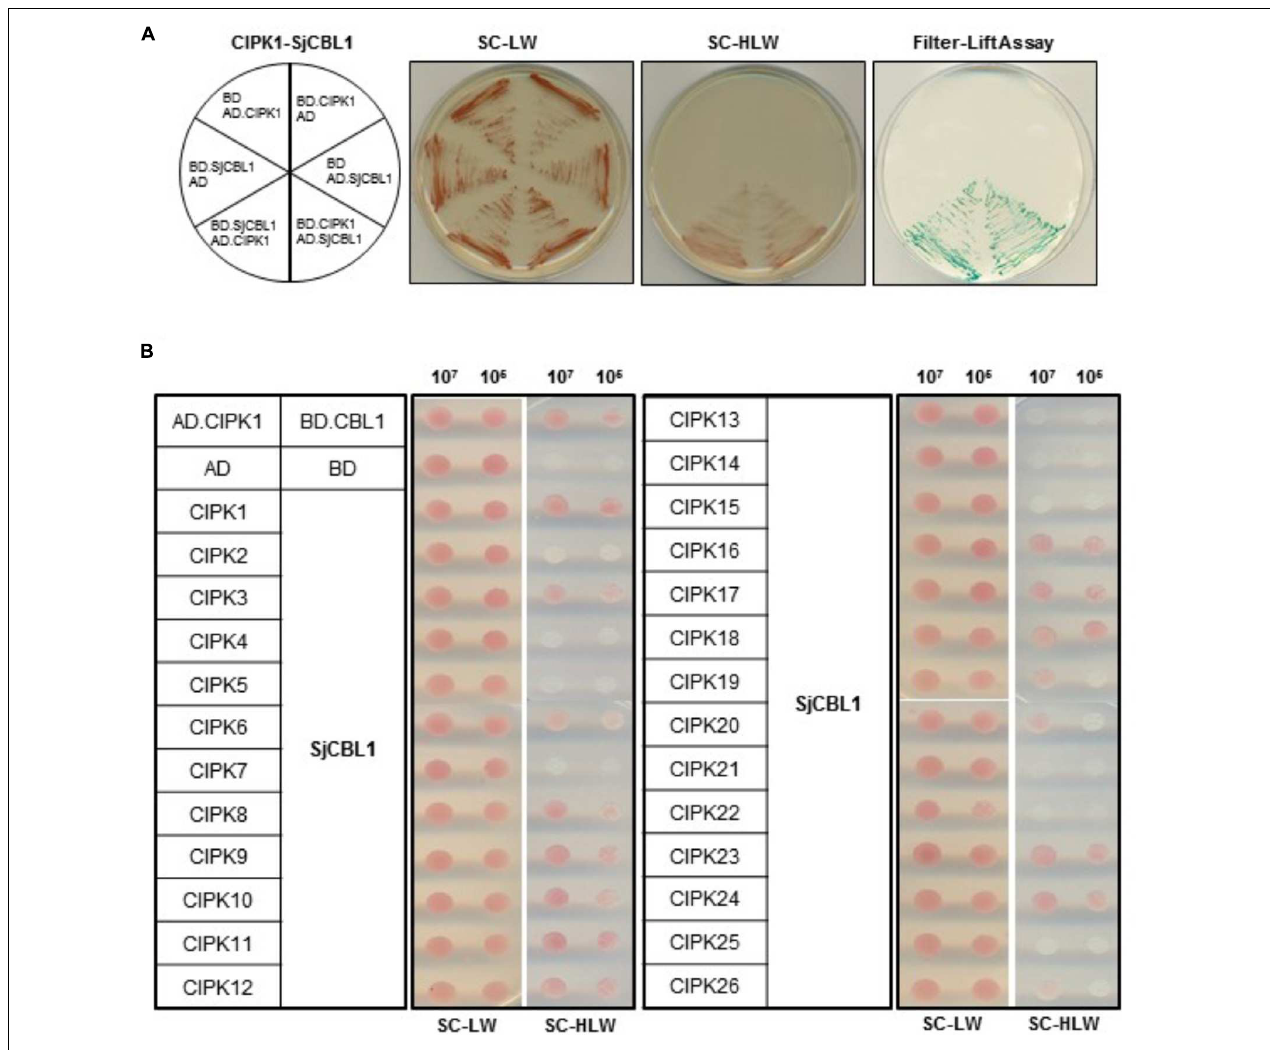
FIGURE 4 | A yeast two-hybrid assay showing that SjCBL1 interacts with multiple members of AtCIPK family. (A) SjCBL1 interacts with AtCIPK1 in a vector-dependent manner. The first panel at left shows the arrangement of the Y109 yeast cells harboring the indicated BD and AD plasmids. The second and third panels display yeast growth on synthetic complete medium lacking Leu and Trp (SC-LW) and synthetic complete medium lacking His, Leu, and Trp (SC-HLW), respectively. The last panel shows β -galactosidase activity using filter-lift assay. (B) Comparative interaction analysis of SjCBL1 with 26 members of the Arabidopsis CIPK family. The yeast cells were cotransformed with the combinations of the BD and AD constructs as indicated at the left. Cotransformed yeast cells were then cultured, serially diluted, and spotted onto the indicated